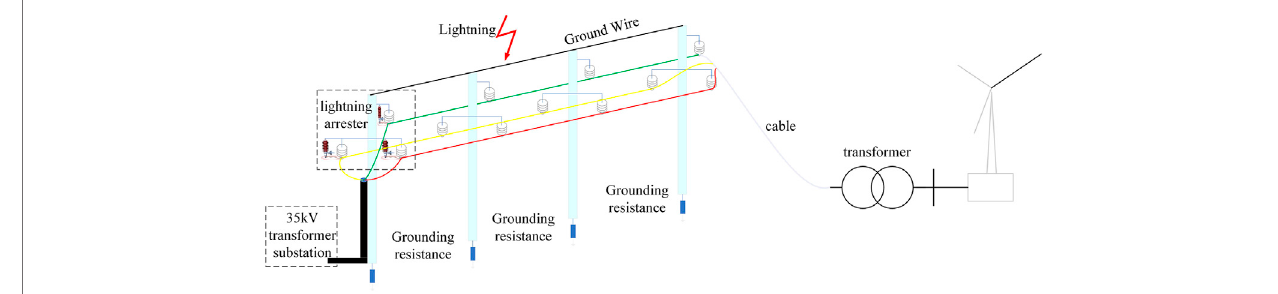
FIGURE 2 | Lightning strikes overhead lines of wind farm.